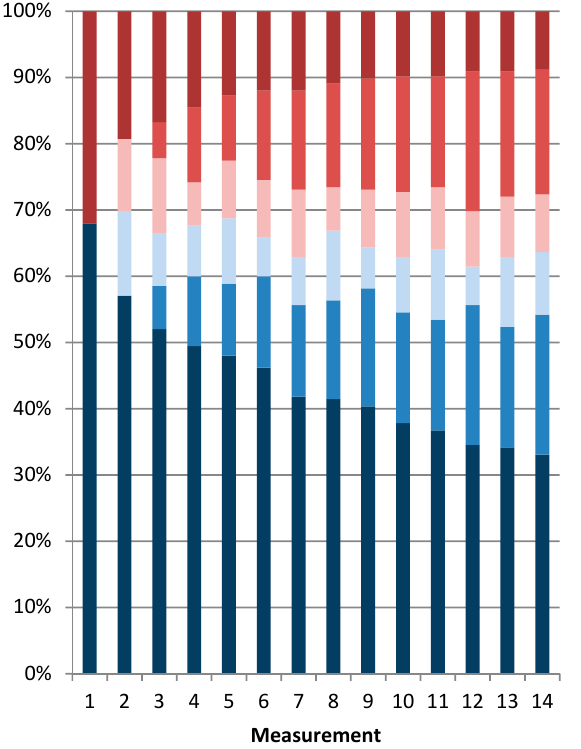
Figure 2. Patterns of low back pain episodes over one year. Int. J. Environ. Res. Public Health 2019 , 16 , x